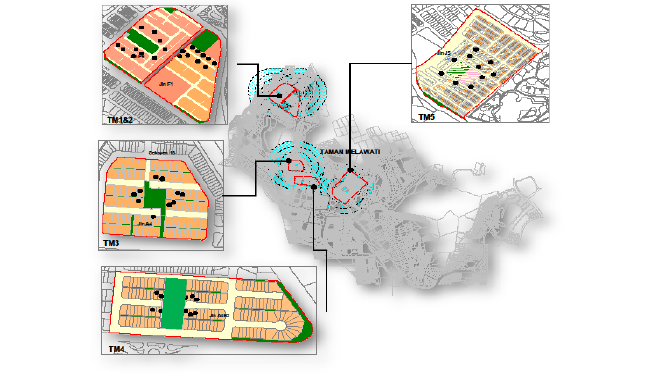
Figure 3: Township of Taman Melawati